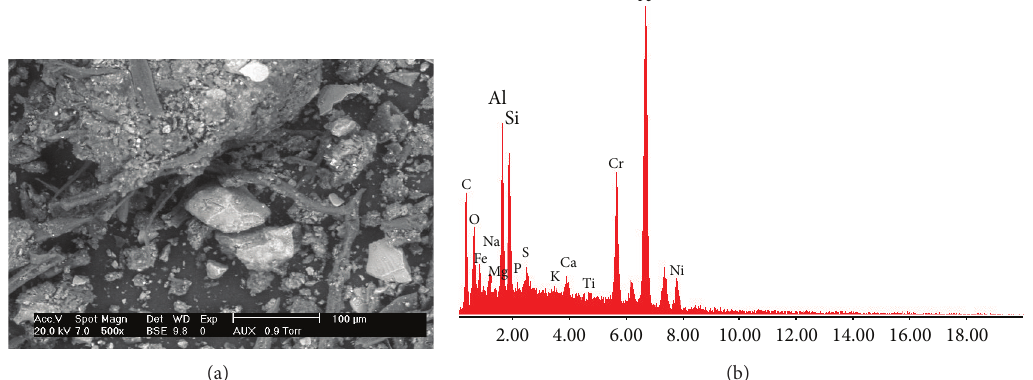
Figure 2: Scanning electron microscopy with X-ray microanalysis (SEM-EDS) image of biosolids (a) and X-ray diffraction (XRD) patterns of biosolids